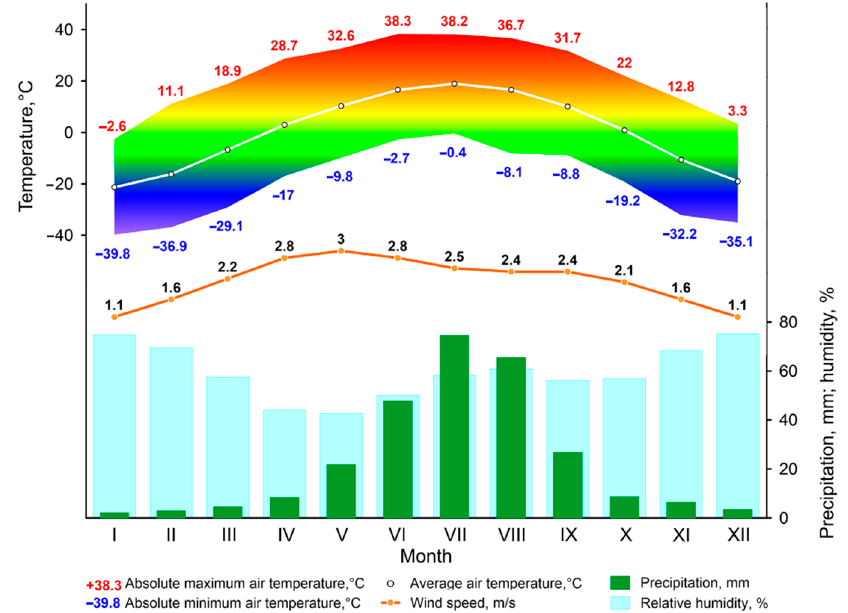
Figure 3. Climate diagram of Ulaanbaatar city (1991–2020).